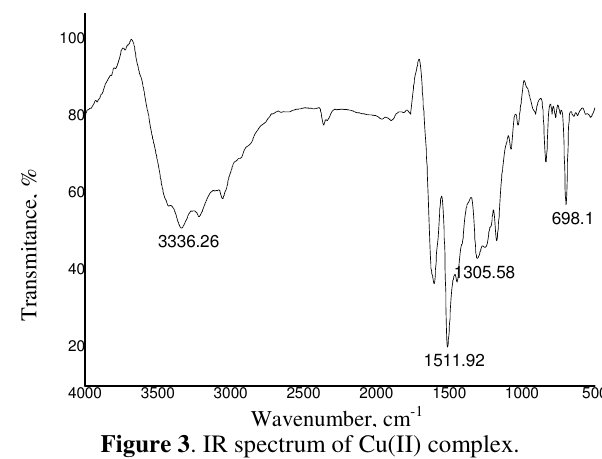
Figure 3 . IR spectrum of Cu(II) complex.